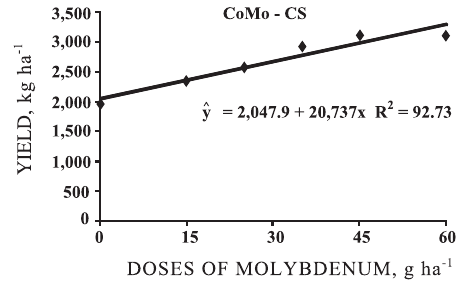
Figure 1. Soybean grain yield as related to seed treatments with Mo and Co doses in concentrated suspension